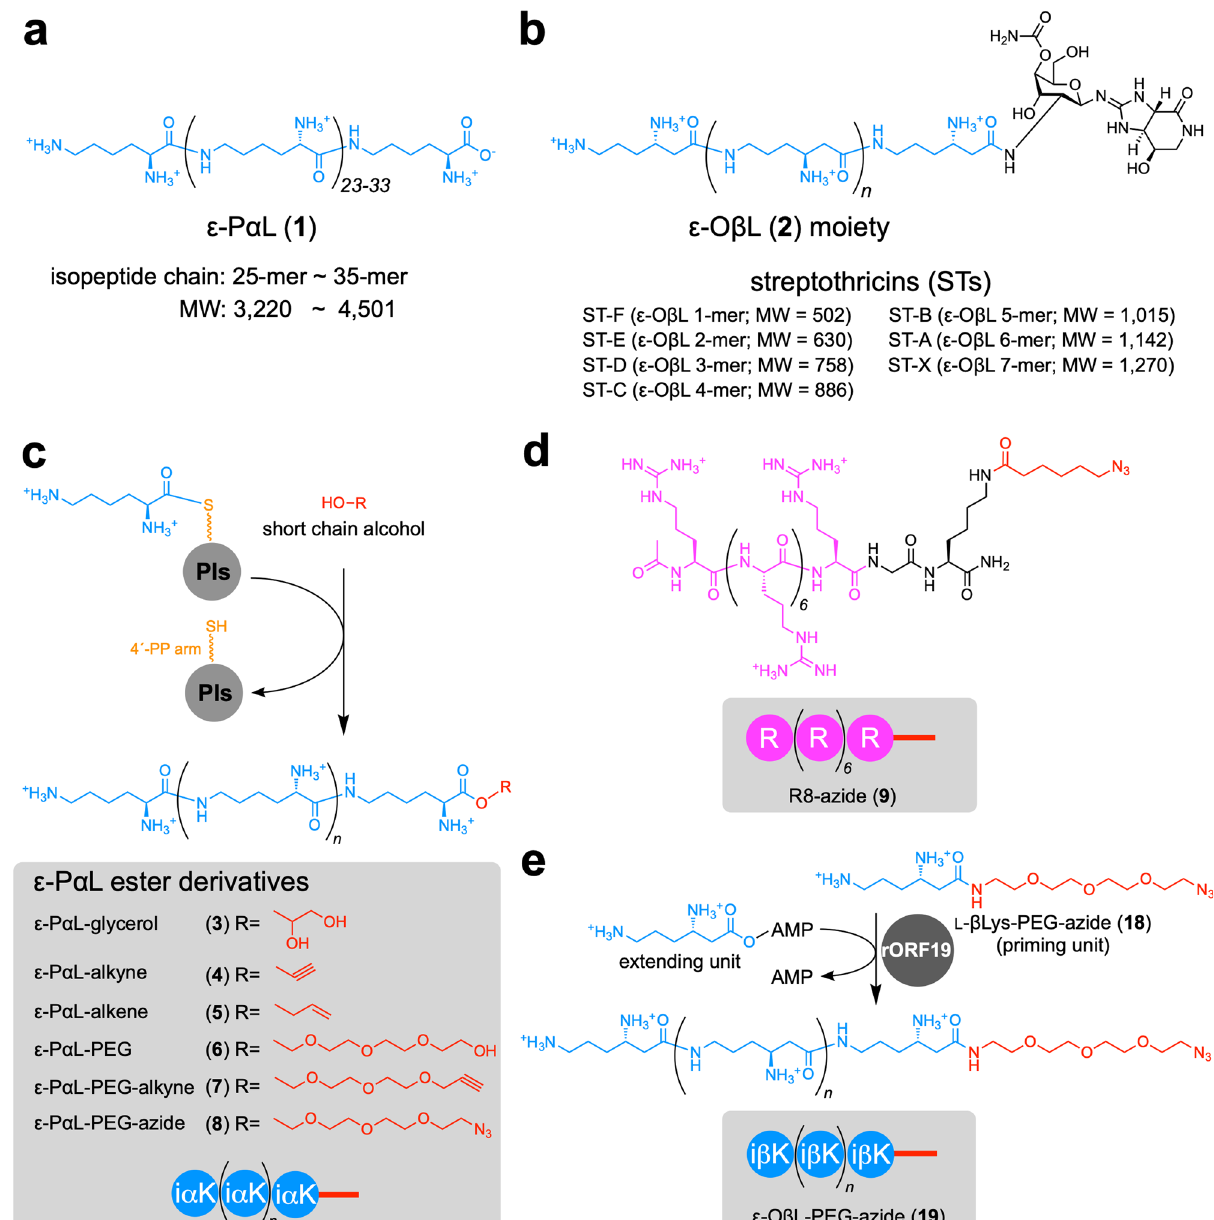
Fig. 1 Polycationic CPPs used in this study. a , b Chemical structures of ε -P α L ( 1 ) and ε -O β L ( 2 ). Polymer 1 consisting of 25 – 35 L - α Lys residues is produced by Streptomyces albulus NBRC14147 as a secondary metabolite ( a ). Oligomer 2 is a substructure of STs. All ST-related compounds consist of carbamoylated D -gulosamine to which 2 (1 – 7 L - β Lys residues) and the amide form of the unusual amino acid streptolidine (streptolidine lactam) are attached. c ε -P α L ester derivatives produced by the NBRC14147 strain in this study. Their C -termini were esteri fi ed with alcohols, and added to the culture media. Pls catalyzed the polymerization of L - α Lys and the esteri fi cation reactions. i α K (light blue circles), isopeptide L - α Lys monomer unit. d The chemical structure of R8-azide ( 9 ). Peptide 9 was chemically synthesized and used as a canonical CPP control. R (light purple circles), α -peptide L -arginine monomer unit. e Enzymatically synthesized ε -O β L-PEG-azide ( 19 ) by rORF19. i β K (light blue circles), isopeptide L - β Lys monomer